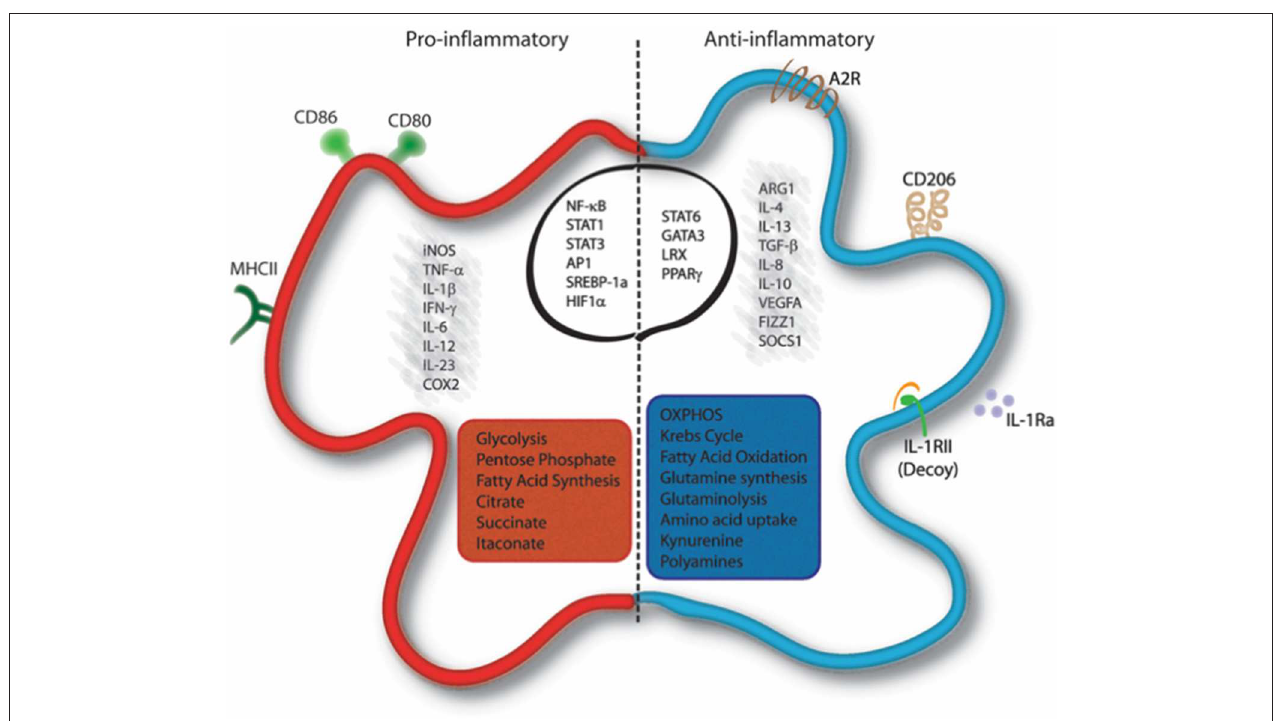
FIGURE 1 | Molecular and metabolic signatures of macrophage activation. Pro-inflammatory stimuli induce the activation of specific pathways through the activation of transcription factors such as NF- κ B, STAT1, STAT3, AP-1, SREBP-1, and HIF1 α , which trigger the expression of markers like iNOS, COX-2, CD80, CD86, and MHC-II and the release of IL-1 β , TNF- α , IFN- γ , IL-6, IL-12, and IL-23. Cells undergo a metabolic reprogramming toward glycolysis, the pentose-phosphate pathway, and fatty acid synthesis. This associates to interruption of the Krebs cycle, ROS formation and efflux of citrate, which supports NADPH and PGE2 synthesis, and succinate, which stabilizes HIF-1 α . Itaconate is produced from citrate and displays antibacterial function. Anti-inflammatory macrophages are characterized by the expression of ARG1, FIZZ1, SOCS1, CD206, Adenosine receptor (A2R), and the decoy IL1RII and by the production of cytokines such as TGF- β , IL-10, IL-4, IL-13, IL-8, IL-1Ra, and VEGFA. Their profile is mainly controlled by the activity of the transcription factors STAT6, GATA3, PPAR γ , and LRX. Metabolically, these cells display enhanced OXPHOS metabolism, fatty acid oxidation, glutaminolysis, tryptophan catabolism with release of kynurenine, and synthesis of polyamines. AP-1, Activator proten 1; ARG1, Arginase 1; COX2, cicloxygenase 2; FIZZ1, Found in inflammatory zone 1; iNOS, inducible Nitric Oxide Synthase; GATA3, GATA binding protein 3; HIF1 α , Hypoxia-inducible factor 1-alpha; IFN- γ , Interferon gamma; LXR, Liver X receptor; MHC-II, major histocompatibility complex class 2; NF- κ B, nuclear factor kappa-light-chain-enhancer of activated B cells; PPAR γ , Peroxisome proliferator-activated receptor gamma; SOCS1, Suppressor of cytokine signaling 1; SREBP-1, Sterol regulatory element binding protein 1; STAT, Signal transducer and activator of transcription; TNF- α , Tumor necrosis factor alpha; TGF- β , transforming growth factor beta; VEGFA, Vascular endothelial growth factor